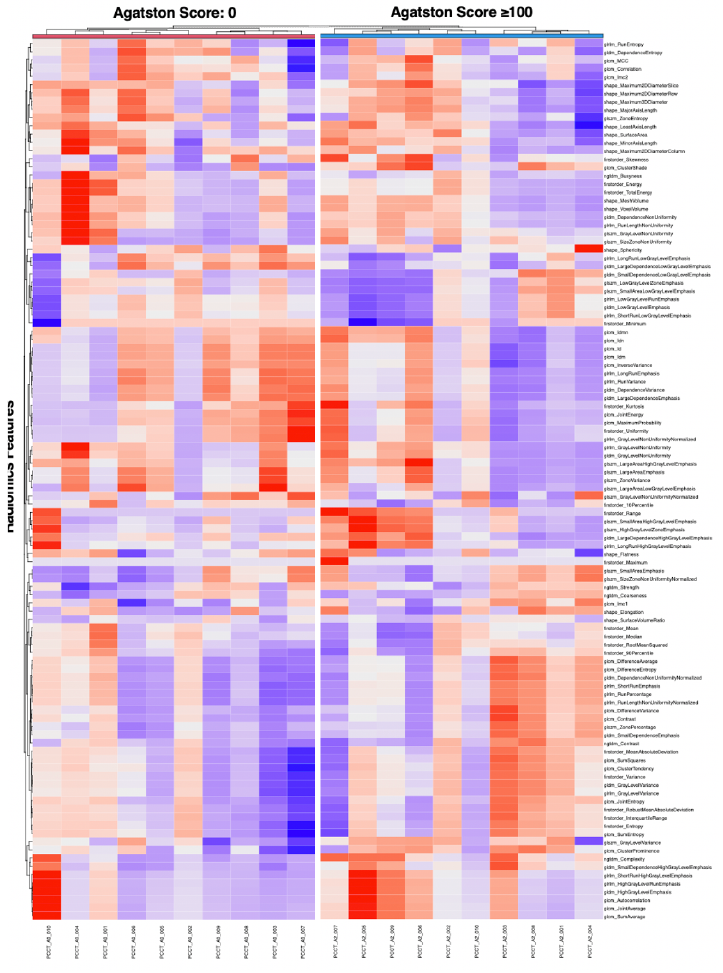
Figure 3. Unsupervised cluster heatmap of myocardial radiomics